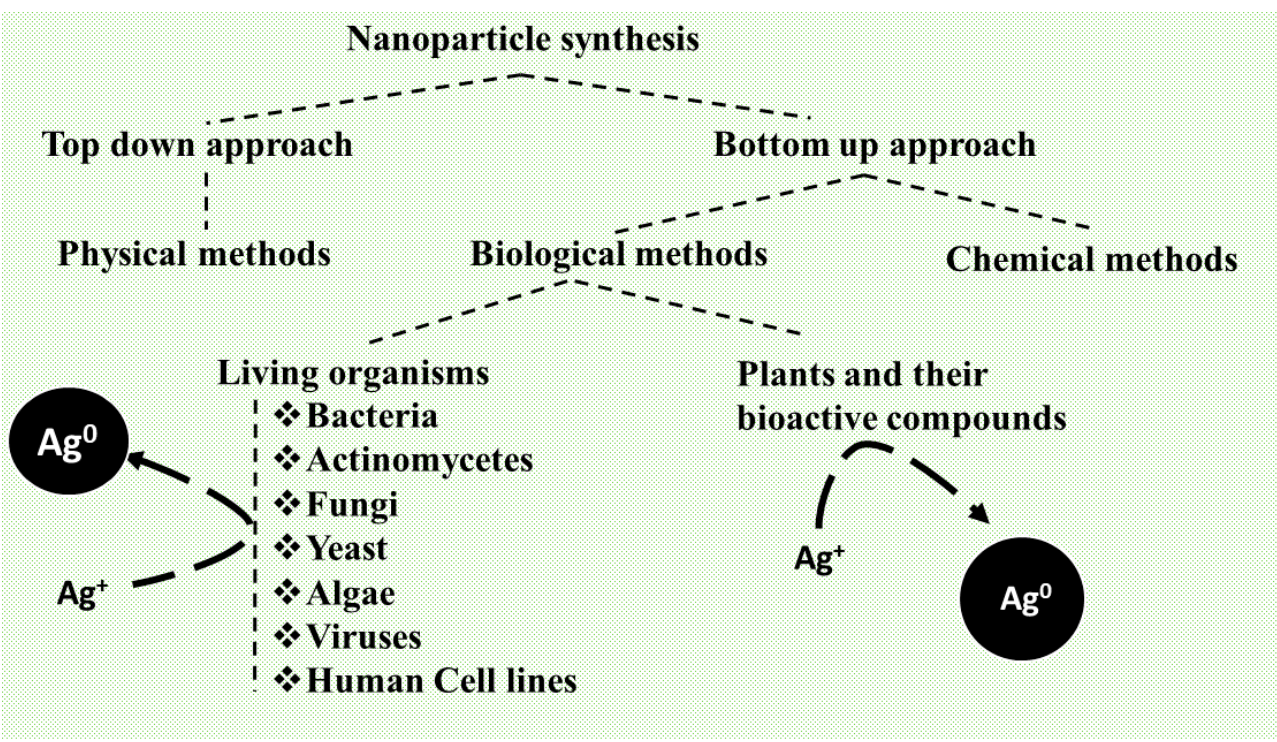
Figure 1. The figure depicts various methods of synthesis of nanoparticles with special emphasis on biogenic method of AgNPs